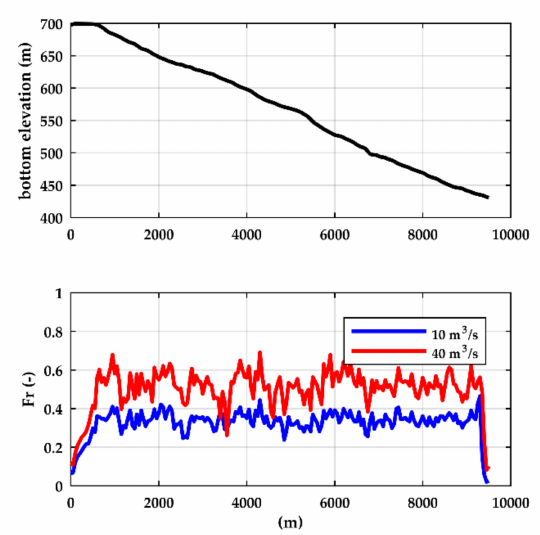
Figure 14. Bottom elevation and Froude number distribution for both simulated